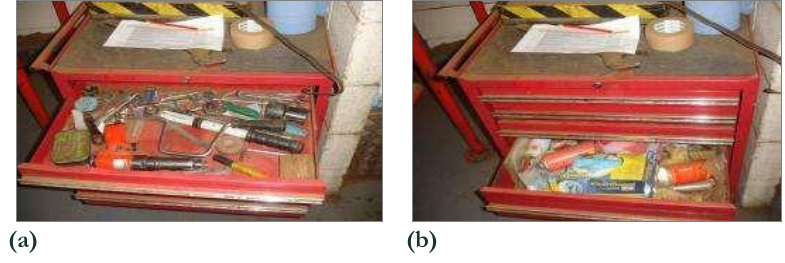
Fig. 1. Current situation of tool set